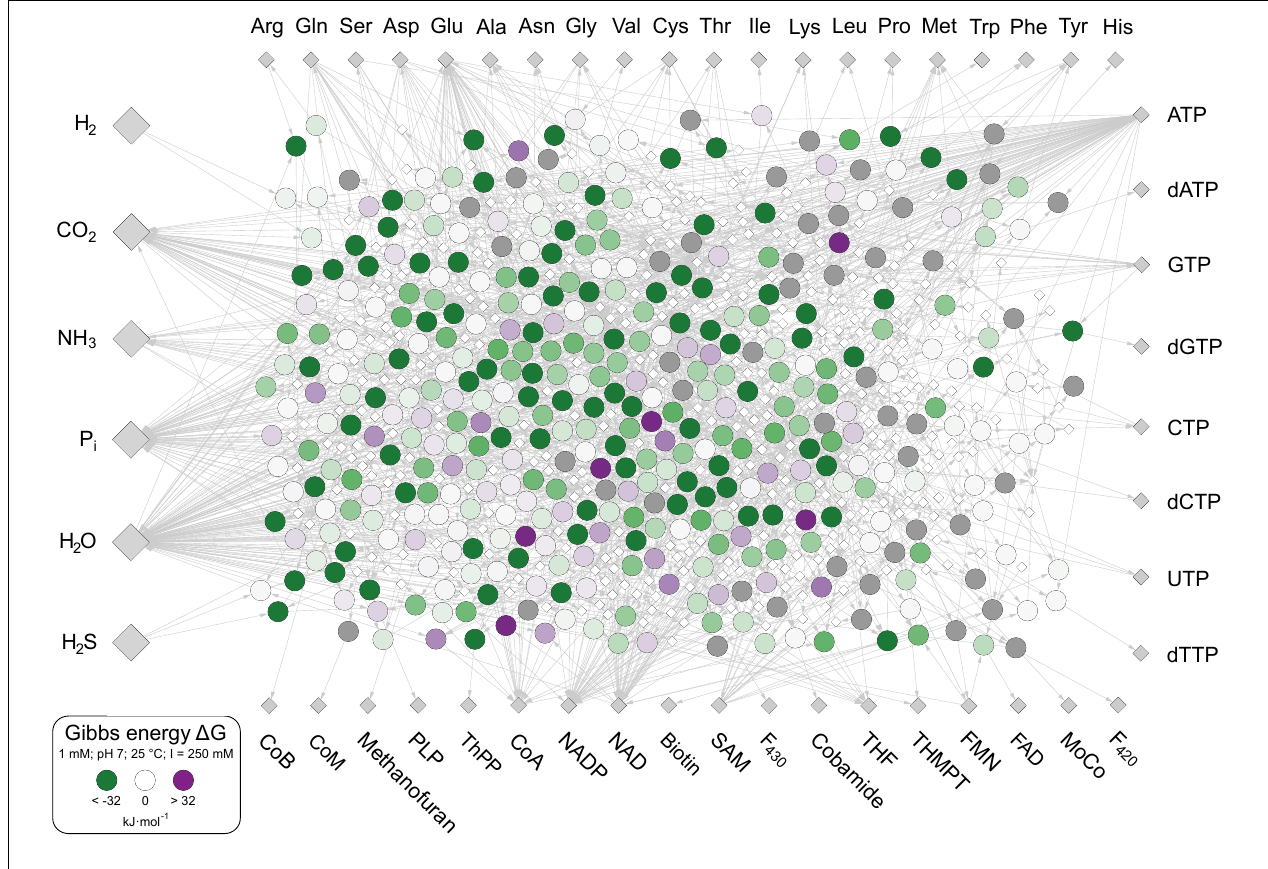
FIGURE 1 | The biosynthetic core. Large gray diamonds: starting compounds (excluding trace elements). Small gray diamonds: products. White diamonds: intermediates. Large circles within the network: Reactions, values of (cid:49) G calculated for 351 reactions at 25 ◦ C, pH 7 and 1 mM equal reactant and product concentration are indicated by large circles and colored according to color scale at lower left. The 51 reactions for which no value of (cid:49) G could be calculated are indicated with dark gray shading. Reactions and values of (cid:49) G given in Supplementary Table 3